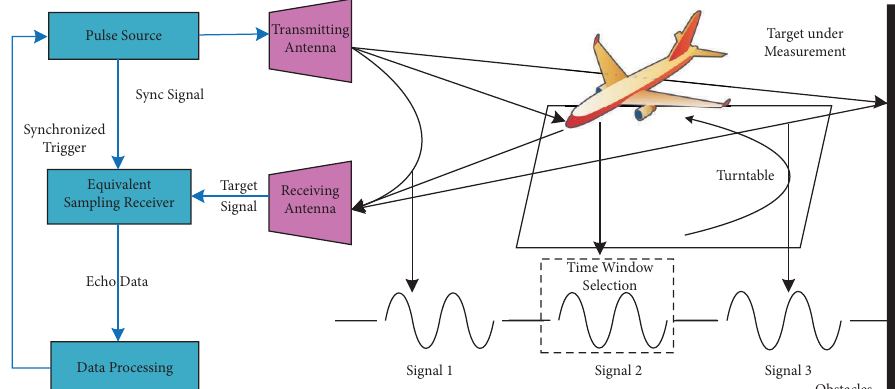
Figure 1: Time domain measurement system hardware block